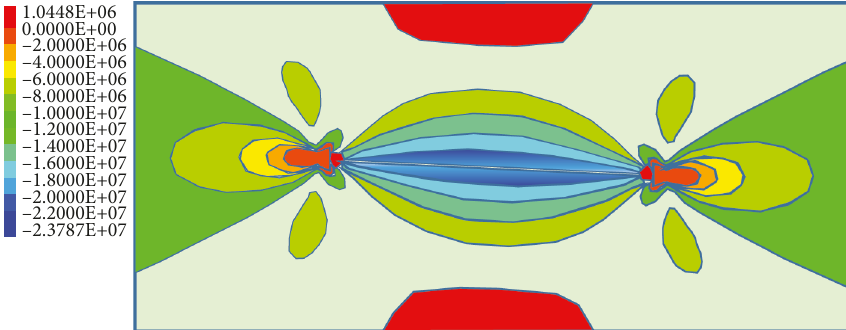
Figure 3: Isoline distribution of disturbed stress in linear elasticity II fault fracture mechanics model.